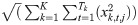
The heatmap of the effect of zk,t to yk,t.The heatmap represents the effect of zk,t to xk,t as an estimated matrix G in the upper part and that of xk,t to yk,t as an estimated matrix H in the bottom part, and thus introduces the indirect effect from zk,t to yk,t. The numbers on horizontal axis mean the element numbers of the 14-dimensional vector xk,t. For example, the column with ‘3’ in the heatmap displays the effect from the 3rd element of the hidden variable xk,t to the observation variables yk,t. For H, each value is normalized as Hi′, j × (∑k=1K∑t=1Tk(xk,t,j2)) and then Hi′,j/max(|H|), where Hi′,j is the i′th row and the jth column element of H and max(|H|) is the max absolute value of H. For G, positive and negative elements are illustrated as red and blue, respectively.